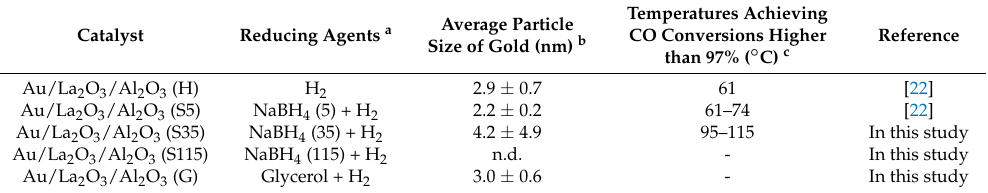
- In this study a The molar ratio of NaBH b The average particle size of gold was determined 4 to Au is included in parentheses; based on the TEM images; c The reaction conditions are same as those in Figure